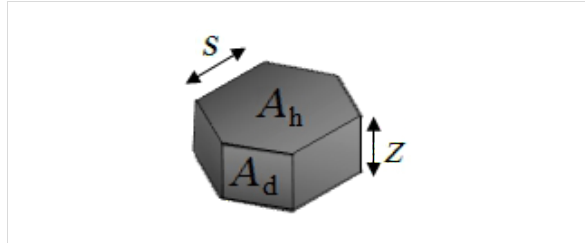
Figure 6: Geometry used for the calculation of the inner surface reduc- tion, with z as the particle thickness and 2 s = D av .